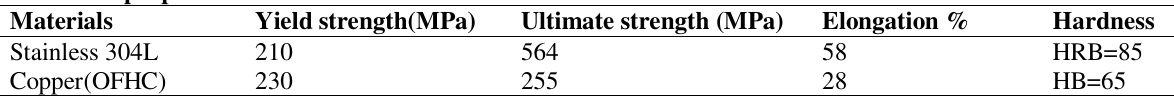
Mechanical properties of two materials used.